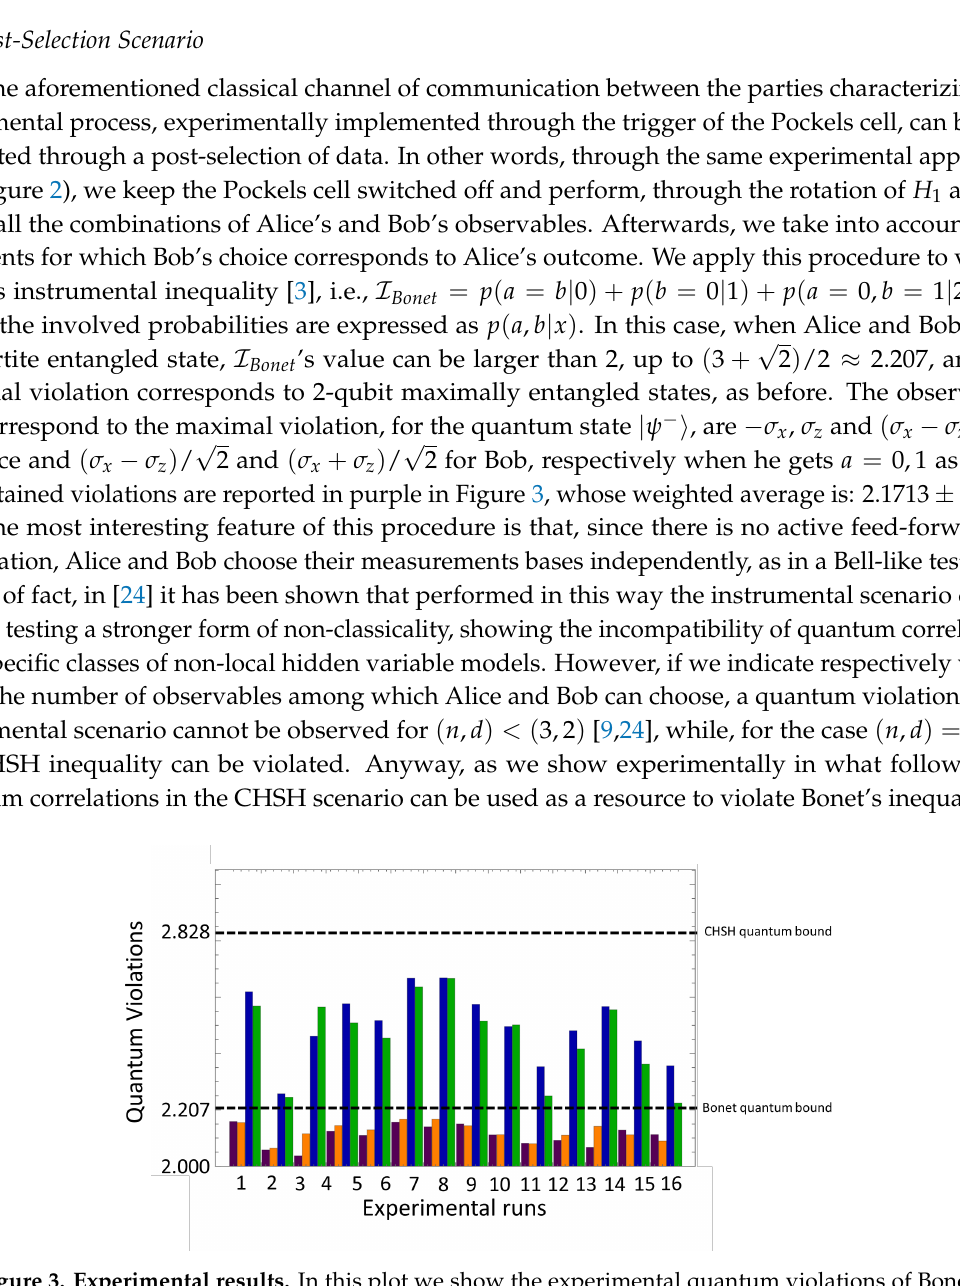
Figure 3. Experimental results. In this plot we show the experimental quantum violations of Bonet and CHSH inequalities obtained from 16 experimental runs in the post-selection regime (for both scenarios the classical upper bound is 2). In purple and blue, we show respectively the Bonet’s and CHSH violations obtained through the apparatus described in Figure 2 section, keeping the Pockels cell switched off and performing Alice’s and Bob’s measurements, rotating the HWPs. In orange, we show the extent of the Bonet inequality’s violation that can be obtained from the probabilities p(a,b|x,y) belonging to the CHSH scenario. In green, we show the CHSH violation obtained on an instrumental process platform, through an alternative procedure which does not require the correlations between all of the 4 combinations of the inputs